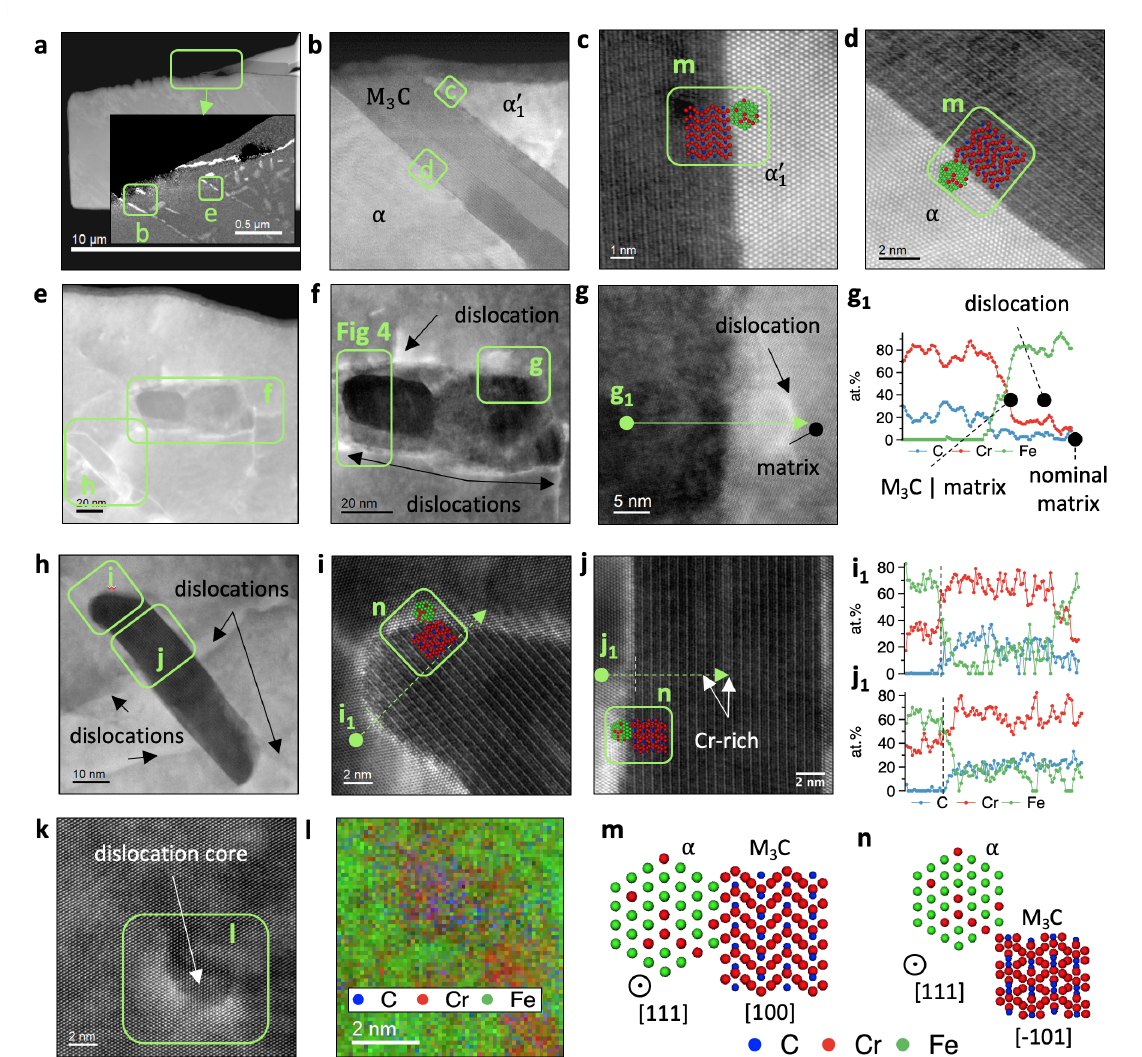
Figure 3. HR STEM investigations for the focused ion beam (FIB) lamella (see Figure 1a). ( a ) An overview of the FIB lamella zooming into the area of interest-magnified and indicated in ( b , e ) in the Cr-EFTEM map. ( b ) A high resolution STEM (HR STEM) image of the inter-phase M 3 C coherent to the reconstructive grown α matrix in ( c ) and the tempered α (cid:48) other side in ( d , e ) shows two intra-phase M 3 C with attached dislocations (indicated with dark arrows) magnified in ( f , h ) indicated with dark arrows. Further indicated for both carbides are the recorded electron energy loss spectroscopy (EELS) chemical line profiles ( g1 , i1 , j1 ) for the elements C, Fe, and Cr. The magnified M 3 C in ( f ) is surrounded by two clouds, while the M 3 C in ( i ) is surrounded only by a thin cloud. The HAADF in ( k ) shows a dislocation core inside the tempered α (cid:48) analysed with the EELS, and the composed RGB image in ( l ) contains elemental maps showing an enrichment of Cr and C inside the dislocation core. ( m , n ) The orientation of M 3 C relative to the